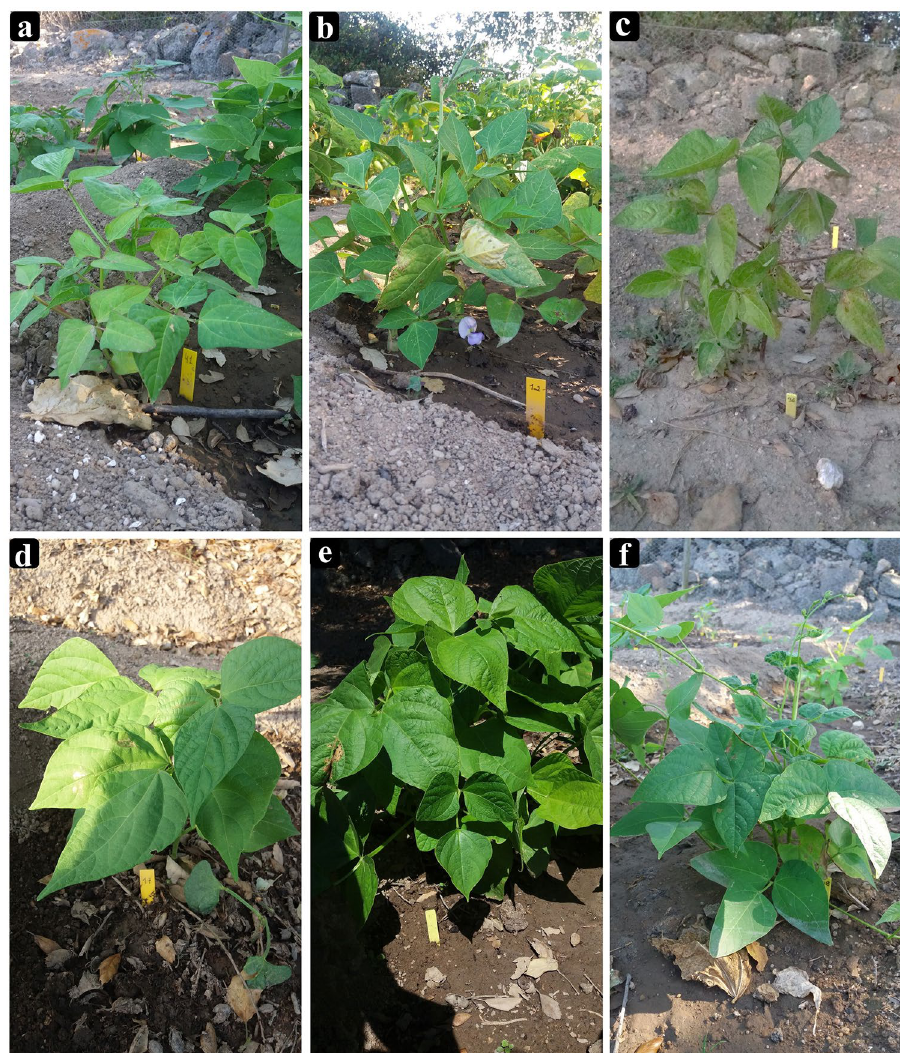
Figure 7. Cultivated samples collected in different African countries: ( a ) Vigna unguiculata from Malanje, Angola (MA41Vu); ( b ) V. unguiculata from Sofala, Mozambique (SO12Vu); ( c ) V. unguiculata from Santiago, Cabo Verde (CV36Vu); ( d ) Phaseolus vulgaris from Cunene, Angola (CU17Pv); ( e ) P. vulgaris from Sofala, Mozambique (SO10Pv); and ( f ) P. vulgaris from Santiago, Cabo Verde (CV38Pv). Plants growth under controlled conditions, between June 2019 and February 2020, at Instituto Superior de Agronomia of the University of Lisbon